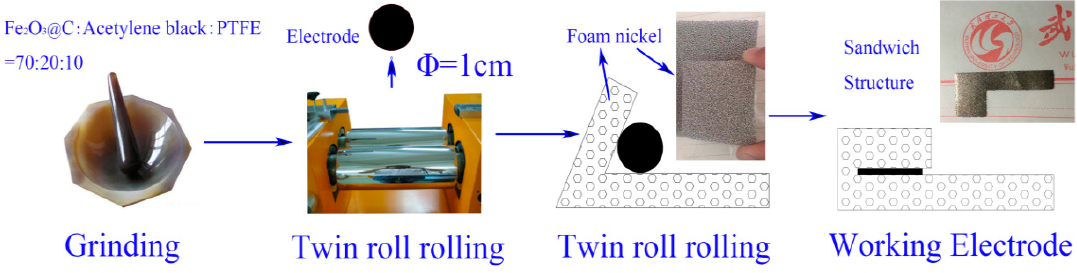
Figure 1. Schematic illustration of preparation of sandwich structure working electrode.